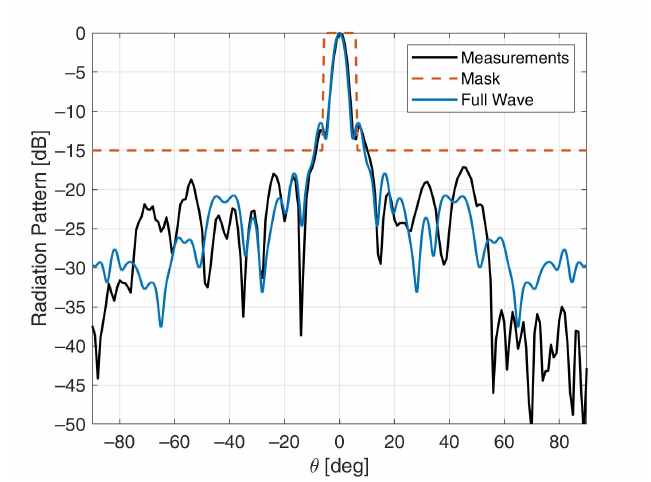
Figure 14. Radiation patterns in the H-plane at 31 GHz.